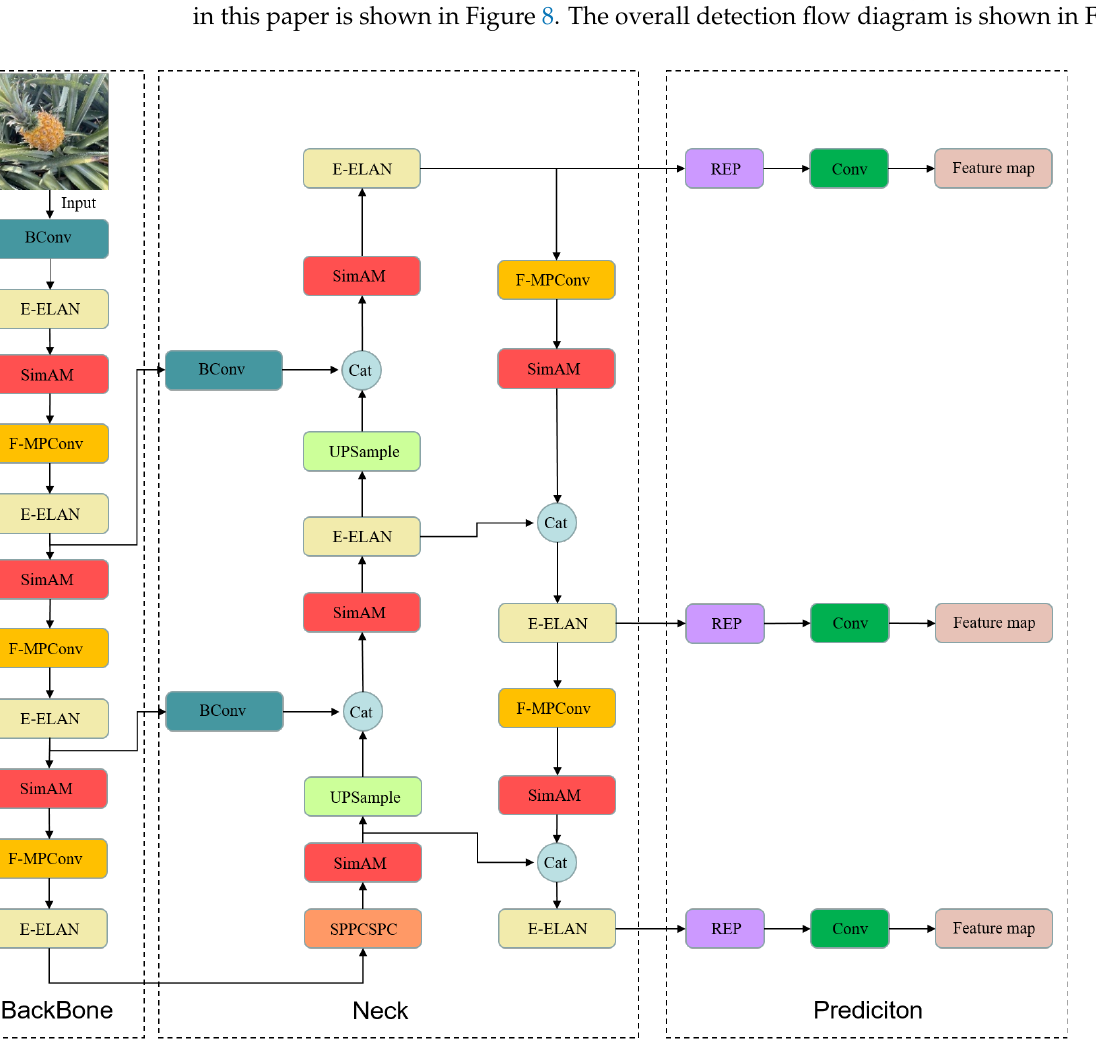
Figure 8. The network structure of the improved YOLOv7.